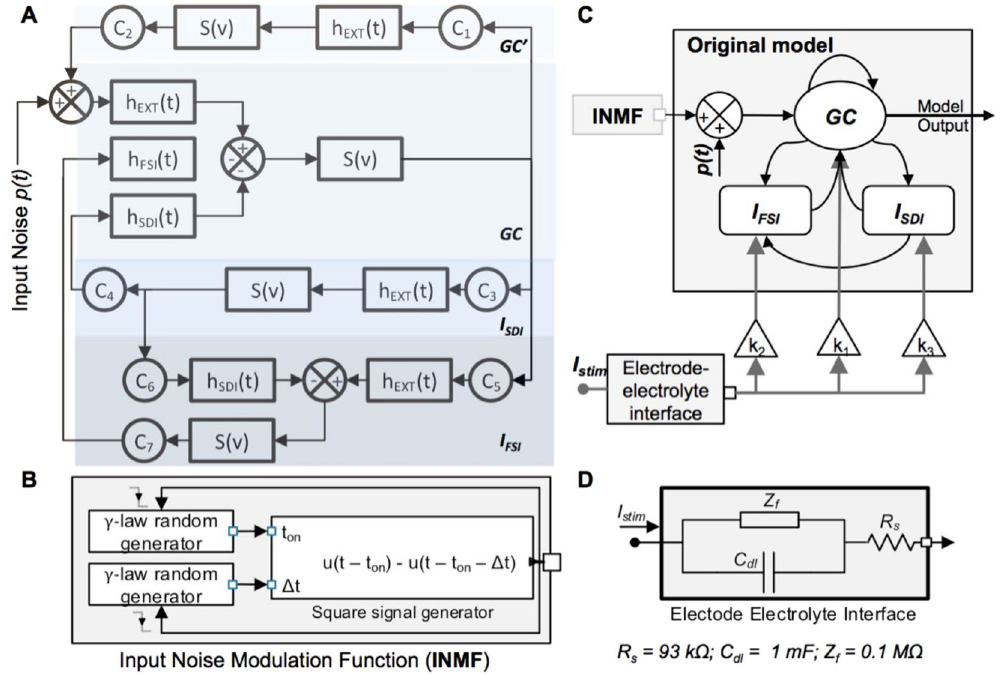
Figure 5. Block diagram of model components. ( A ) Block diagram of the neural mass model, illustrating the considered neural populations and h-functions describing post-synaptic potentials. ( B ) Block diagram of the Input Noise Modulation Function (INMF) for HPD generation. ( C ) Block diagram of the two novel components of the extended neural mass model, including the INMF for HPD simulation, and electrode- electrolyte model with population-dependent coupling coefficients (k 1 , k 2 , k 3 ) to simulate LDCS effects. ( D ) Detail of the electrode-electrolyte